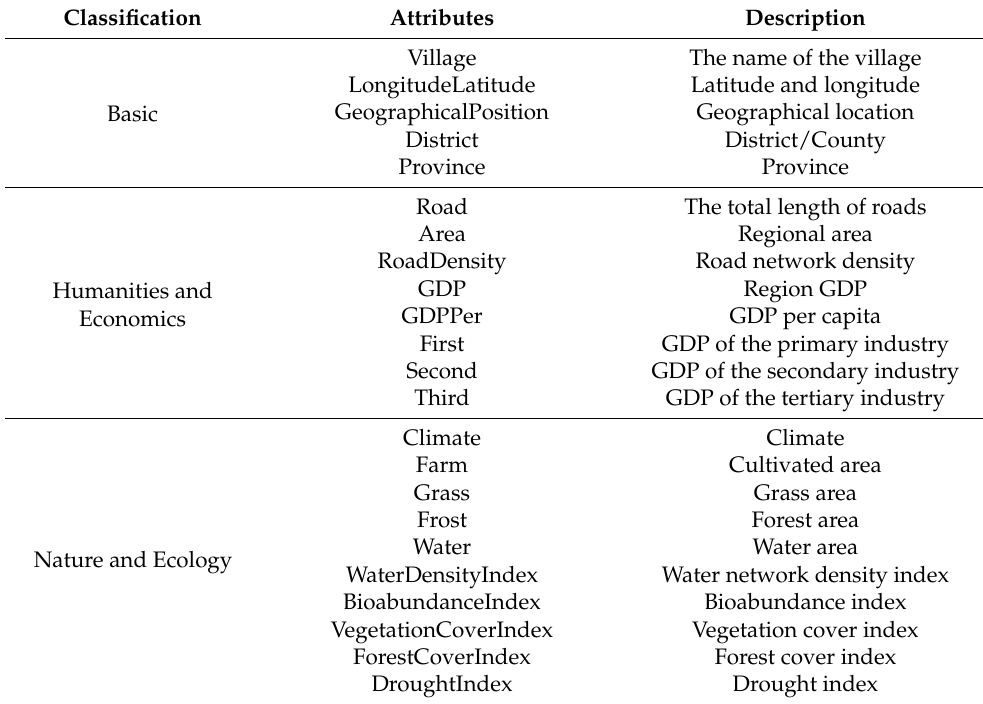
Table 3. The attributes information of the sample point.